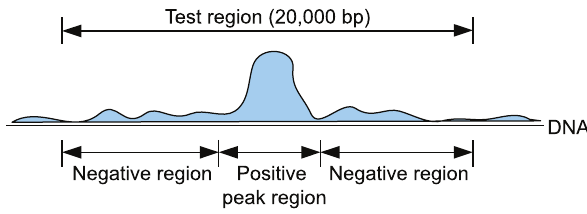
Figure 1. Defining positive and negative regions for the site benchmark. The maximum score in each region is used to calculate the ROC curve. In the site benchmark, the negative regions around a peak are further divided into smaller regions of length 200 bp (not shown). The promoter benchmark is based on the same principle as the site benchmark, but the test regions are then derived from regions surrounding gene transcription start sites and from first introns, and the negative regions are not further divided into smaller